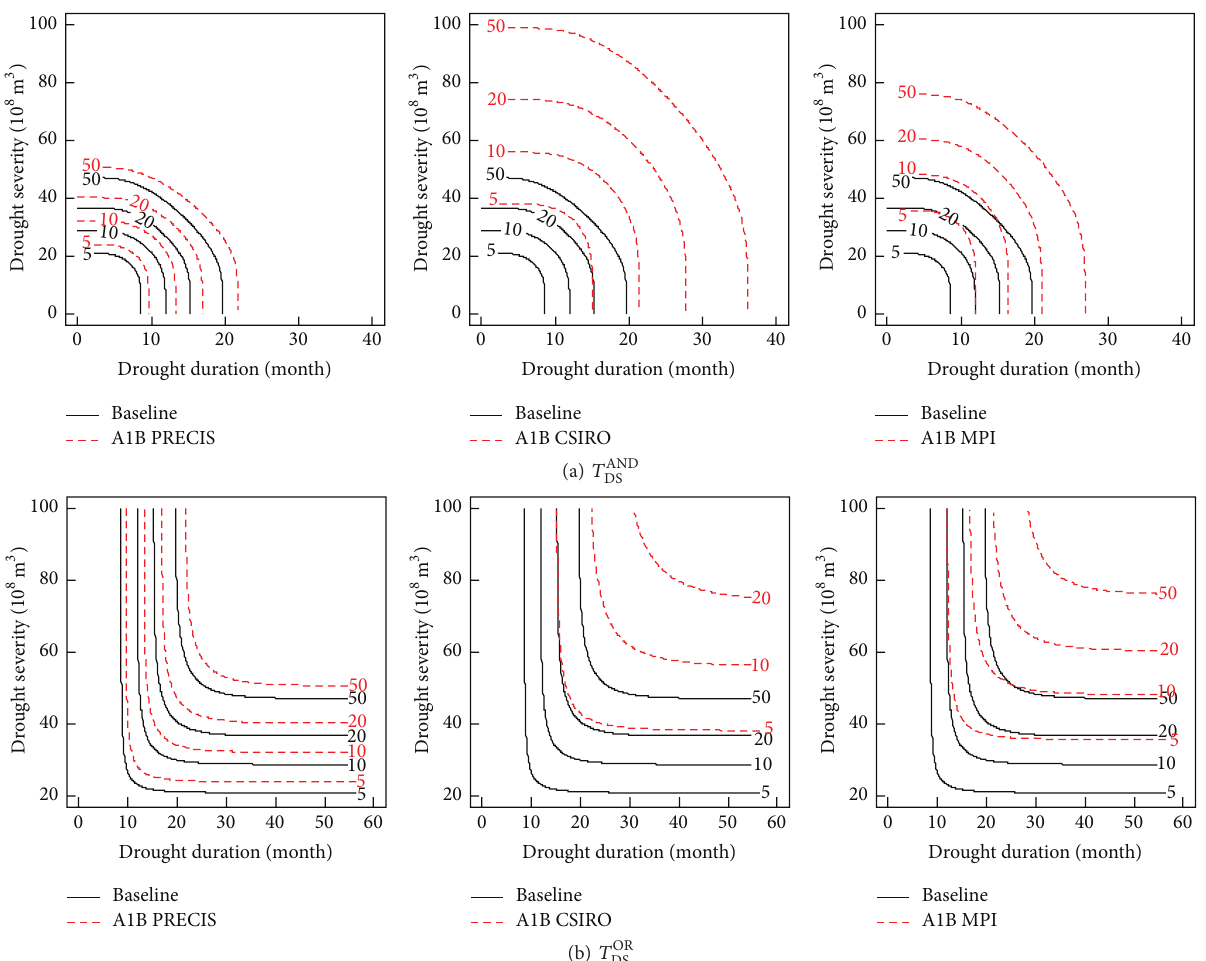
Figure 10: Bivariate joint return periods of drought duration and severity under baseline and A1B scenarios: (a) 𝑇 AND DS defined by (7) and (b) 𝑇 OR DS defined by